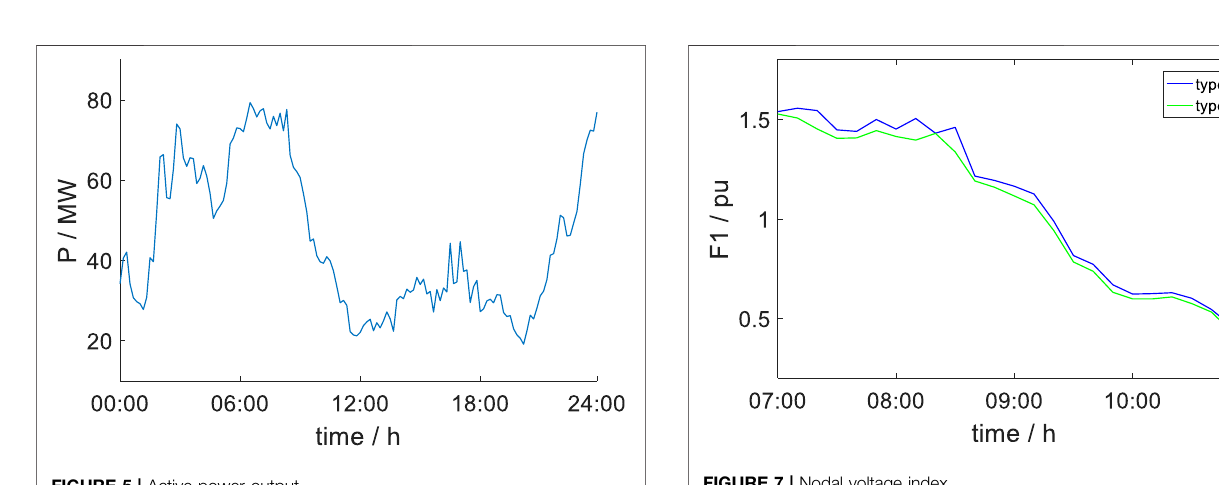
FIGURE 4 | Flow chart for reactive power and voltage control of WFs.